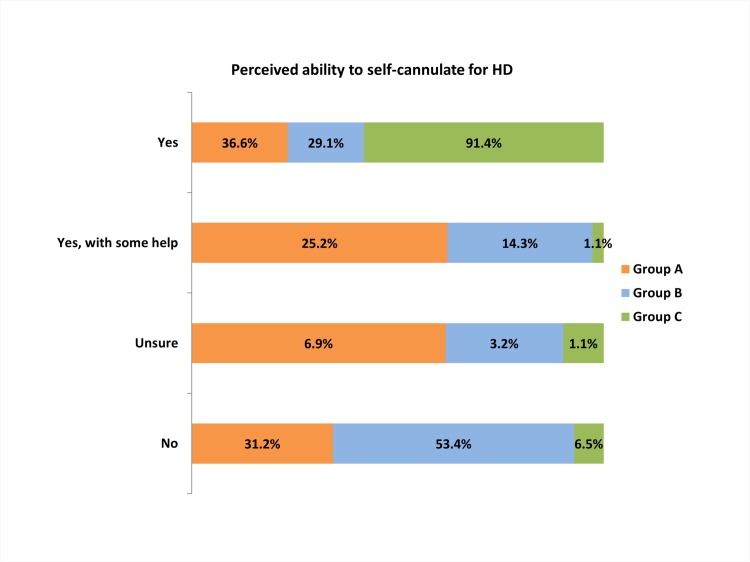
Bar chart shows the perceived ability of patients in the three study groups to self-cannulate.
Group A: Predialysis cohort; B: Hospital haemodialysis cohort; C: Home haemodialysis cohort.